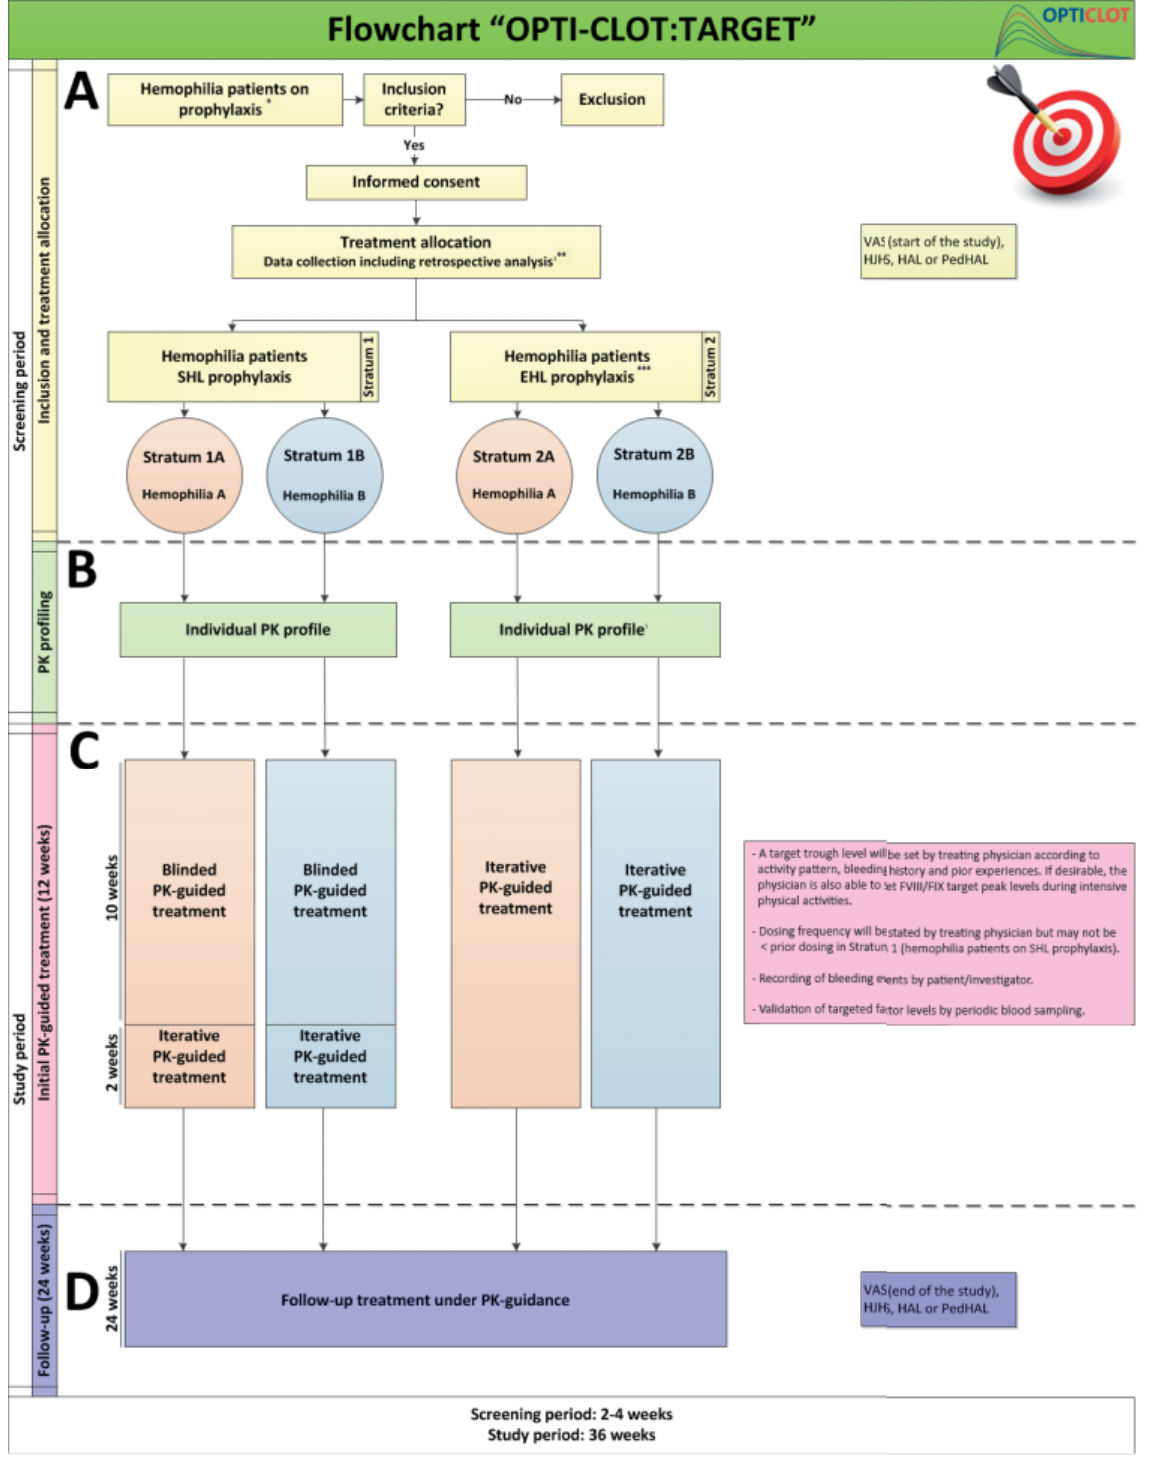
Fig. 1 Flow chart. EHL, extended half-life; HAL, Hemophilia Activity List; HJHS, Hemophilia Joint Score; PedHAL, pediatric HAL; PK, pharmacokinetic(s); SHL, standard half-life; VAS, visual analogue scale (cid:1) Non severe hemophilia patients will be analyzed separately. (cid:1)(cid:1) In parallel with the prospective study, retrospective data analysis will be performed over a 12 month period prior to inclusion (if no PK pro fi ling has been performed) or from PK pro fi ling prior to inclusion. (cid:1)(cid:1)(cid:1) Patients in stratum 2 could undergo PK pro fi ling during SHL prophylaxis as well as during EHL prophylaxis.